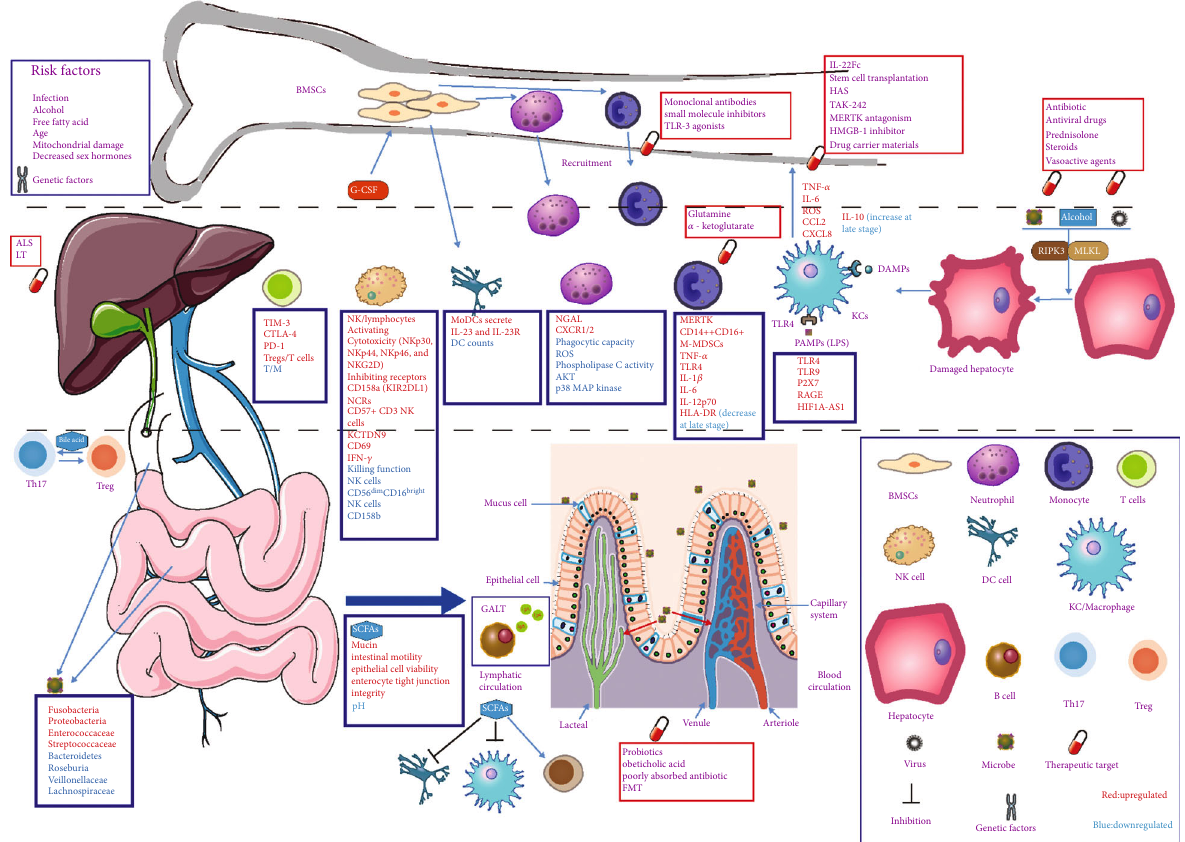
Figure 3: Mechanism by which the immune system and microorganisms jointly promote ACLF formation. DAMPs produced by damaged liver cells or PAMPs produced by pathogens are recognized by PRRs on macrophages/KCs, which are activated and release in fl ammatory factors and chemokines, and recruit neutrophils and monocytes. Along with BMSCs, DCs are activated, and NK cells, T cells, and B cells are consumed, inducing systemic in fl ammation. Various changes of cell surface factor and regulatory factor, immune metabolic disorders, and liver bile secretion decreased; regulation of TH17/Treg obstacle, late performance for immunosuppression and abnormal lipid metabolism, and the role of short-chain fatty acids regulate intestinal function decline, the intestinal barrier damage, and gut bacteria translocation, aggravating infection, and liver cell damage are aggravating, forming a vicious